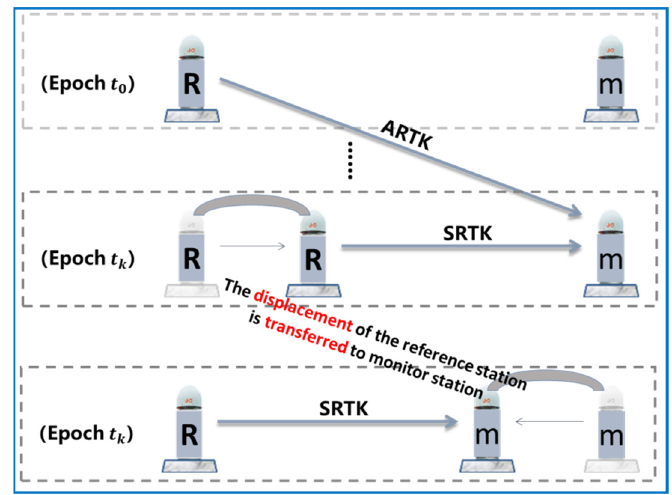
Figure 6. Displacement sequence obtained with CD02 as the reference station and CD01 as the monitoring station. E—east; N—north; U—upward.